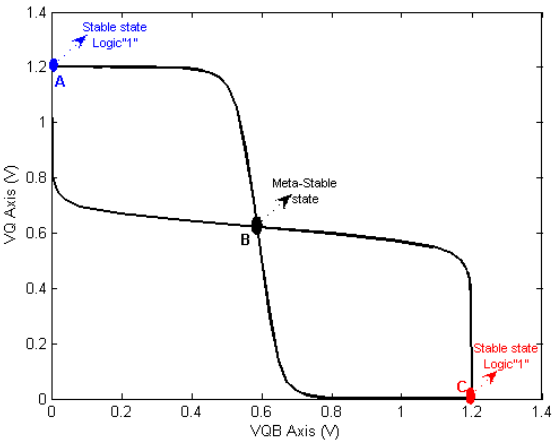
Figure 2. Butterfly plot of the SRAM cell. A and B are stable states, and C is metastable. When V dd is raised (SRAM power-up), cells are kept in hold operation, i.e., access